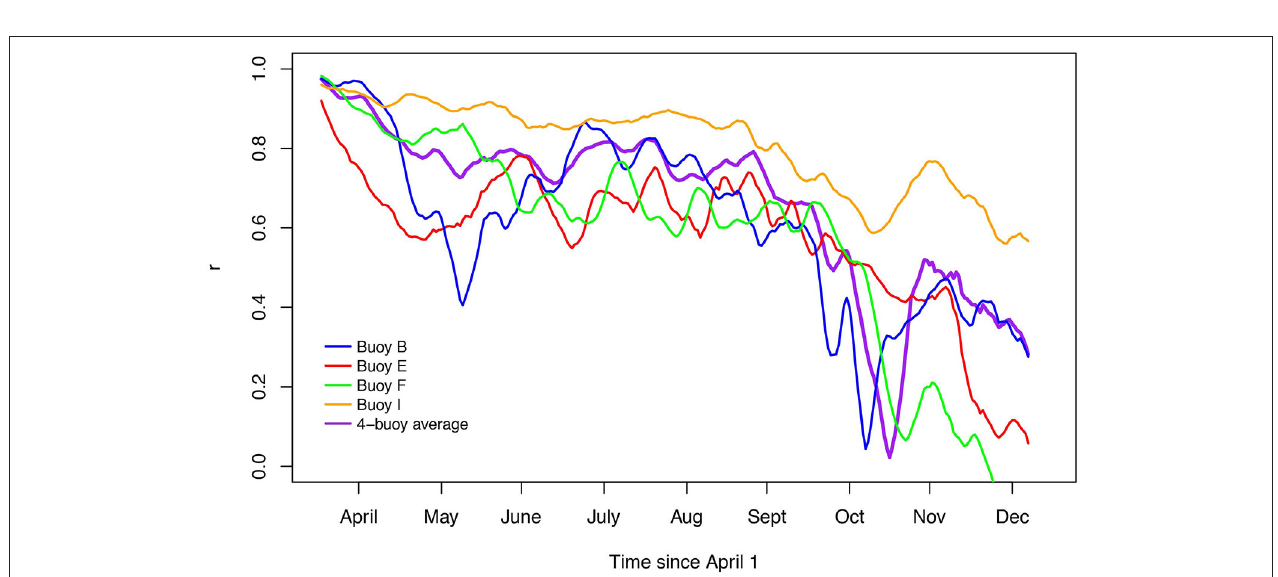
FIGURE 4 | Persistence of correlation to April 1 temperature. Correlation of 50-m temperatures at four buoys on April 1 to temperatures on subsequent days of the year. Statistically significant correlations persist through early to mid-October at Buoys B, E, and F; through mid-November for the 4-buoy average; and through the end of the year for Buoy